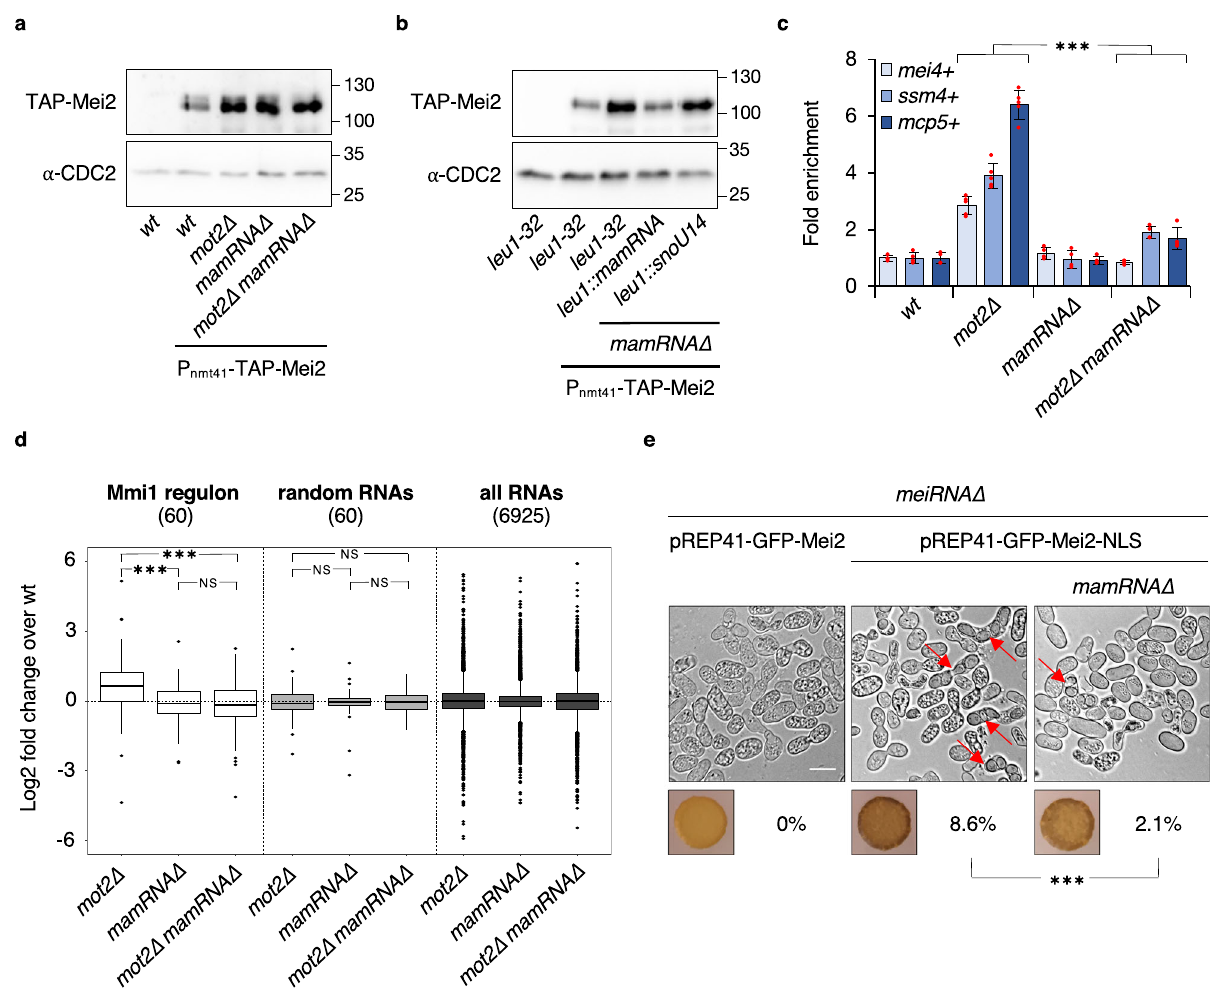
Fig. 3 mamRNA mediates the Mmi1 – Mei2 mutual control. a , b Western blots showing total TAP-tagged Mei2 levels in cells of the indicated genetic backgrounds. Anti-CDC2 antibody was used as loading control. In b , mamRNA or snoU14 were integrated at the leu1 + locus. c RT-qPCR analyses of mei4